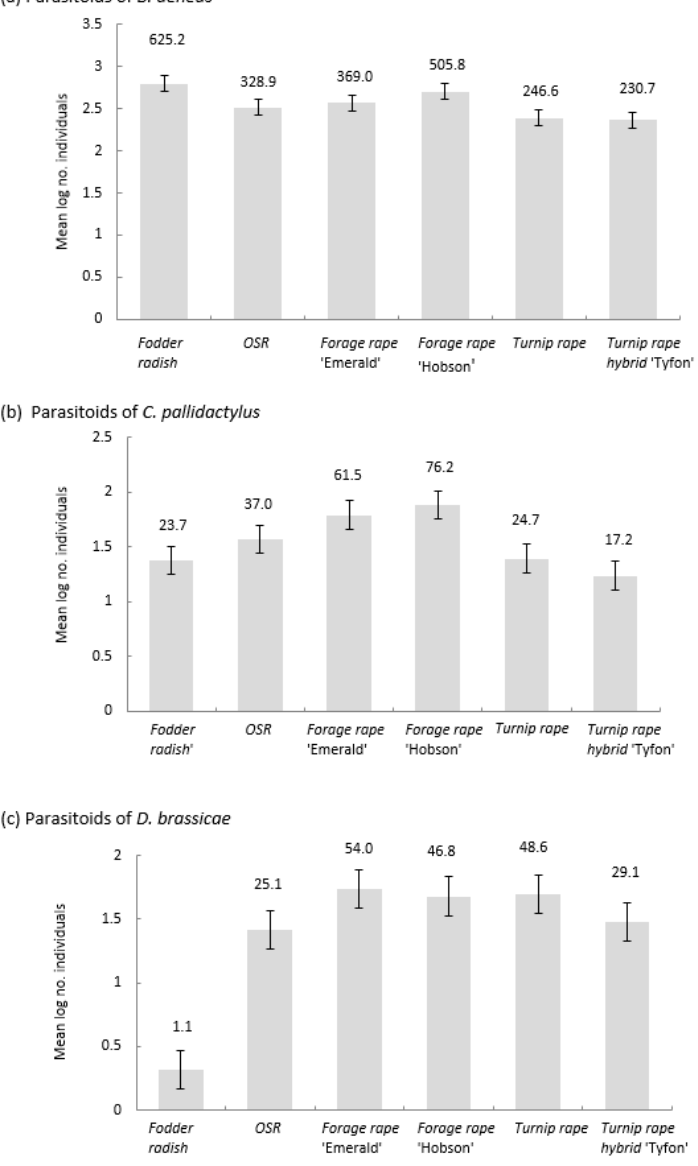
Figure 7. Mean number (log scale, ± SEM) of parasitoids of ( a ) Pollen beetle ( Brassicogethes aeneus ), ( b ) Cabbage stem weevil ( Ceutorhynchus pallidactylus ), and ( c ) Brassica pod midge ( Dasineura brassicae ) captured emerging from the site of different Brassicaceae plots ( n = 4): Fodder radish ( Raphanus sativus ) cv Apoll; Oilseed rape (OSR; Brassica napus ) cv Castille; Forage rape ( Brassica napus ) cv Emerald and cv Hobson; Turnip rape ( Brassica rapa ) cv Jupiter and Tyfon (a hybrid of B. rapa Rapifer group × B. rapa Pekinensis group). Back-transformed values are shown above each bar.